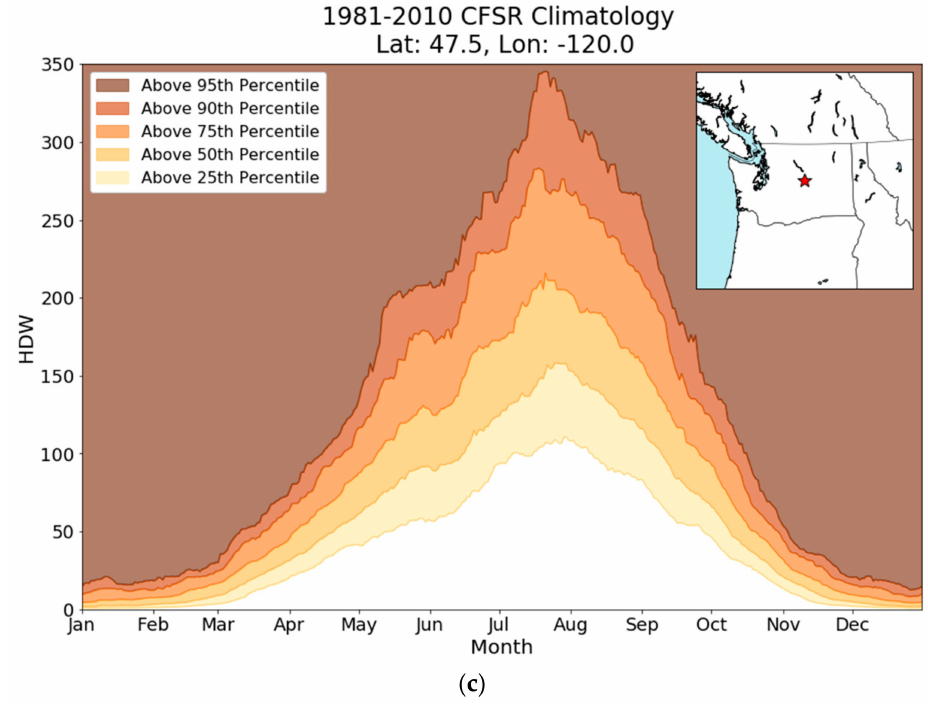
Figure 3. As in Figure 1, but for grid points at ( a ) 47.5 ◦ N, 124.0 ◦ W; ( b ) 47.5 ◦ N, 122.0 ◦ W; and ( c ) 47.5 ◦ N, 120.0 ◦